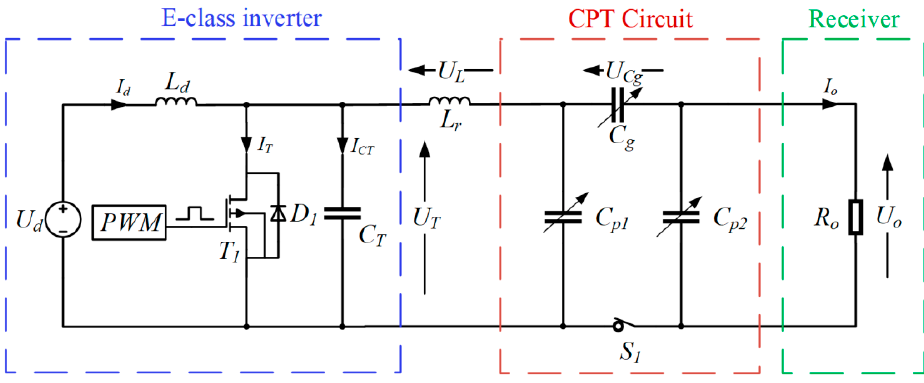
Figure 4. The structural schema of the considered CPT system.